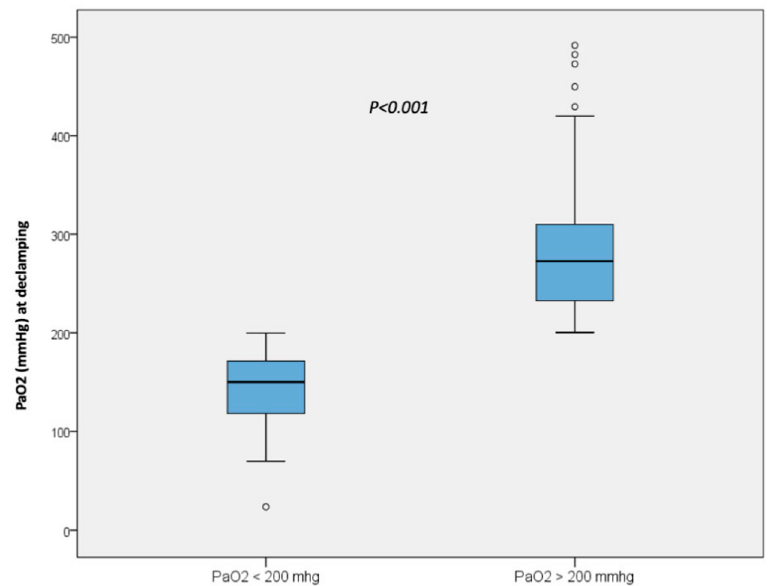
Figure 1. PaO 2 at declamping in the non-hyperoxic group and in the hyperoxic group. The groups were comparable across all demographic criteria, anthropomorphic criteria, liver transplantation indications and preoperative laboratory data assessment (Table 1). Table 1. Characteristics of